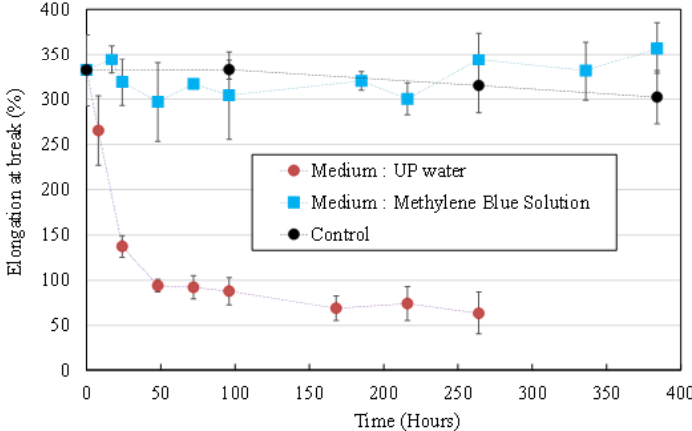
Figure 5. Elongation at break measured on HFs irradiated at 1000 µW/cm² in an MB solution ( blue squares ), in UP water ( red dots ). Control is non-irradiated HFs in an MB solution ( black dots ).